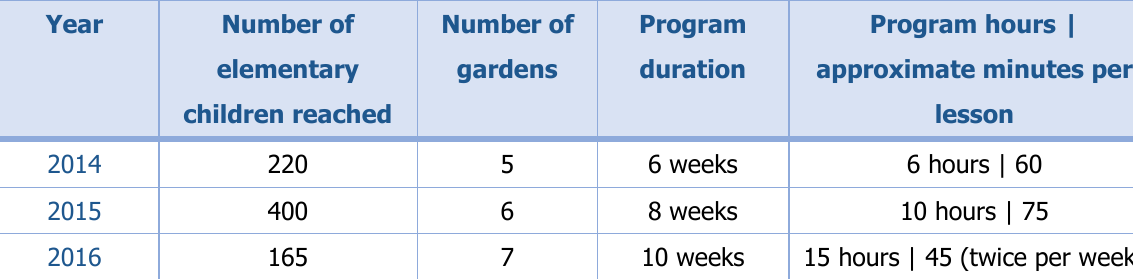
Table 6. Number of Elementary Children Participating in HLA Garden Program